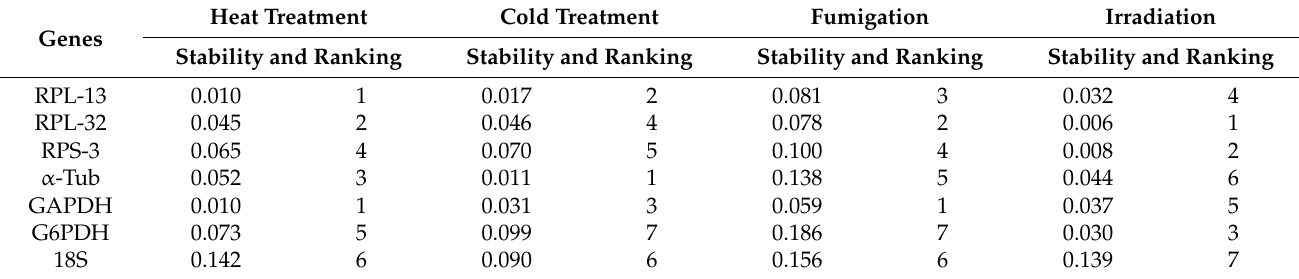
Table 5. Gene expression stability of tested reference genes of B. dorsalis exposed to different phytosanitary treatments analyzed using NormFinder.